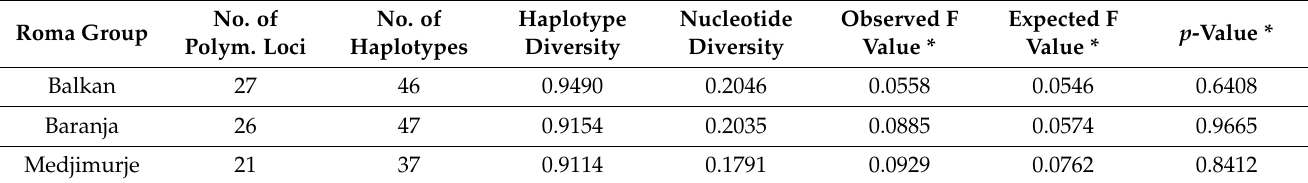
Table 2. Intra-population diversity and results of the Ewens–Watterson test of selective neutrality. Roma Group